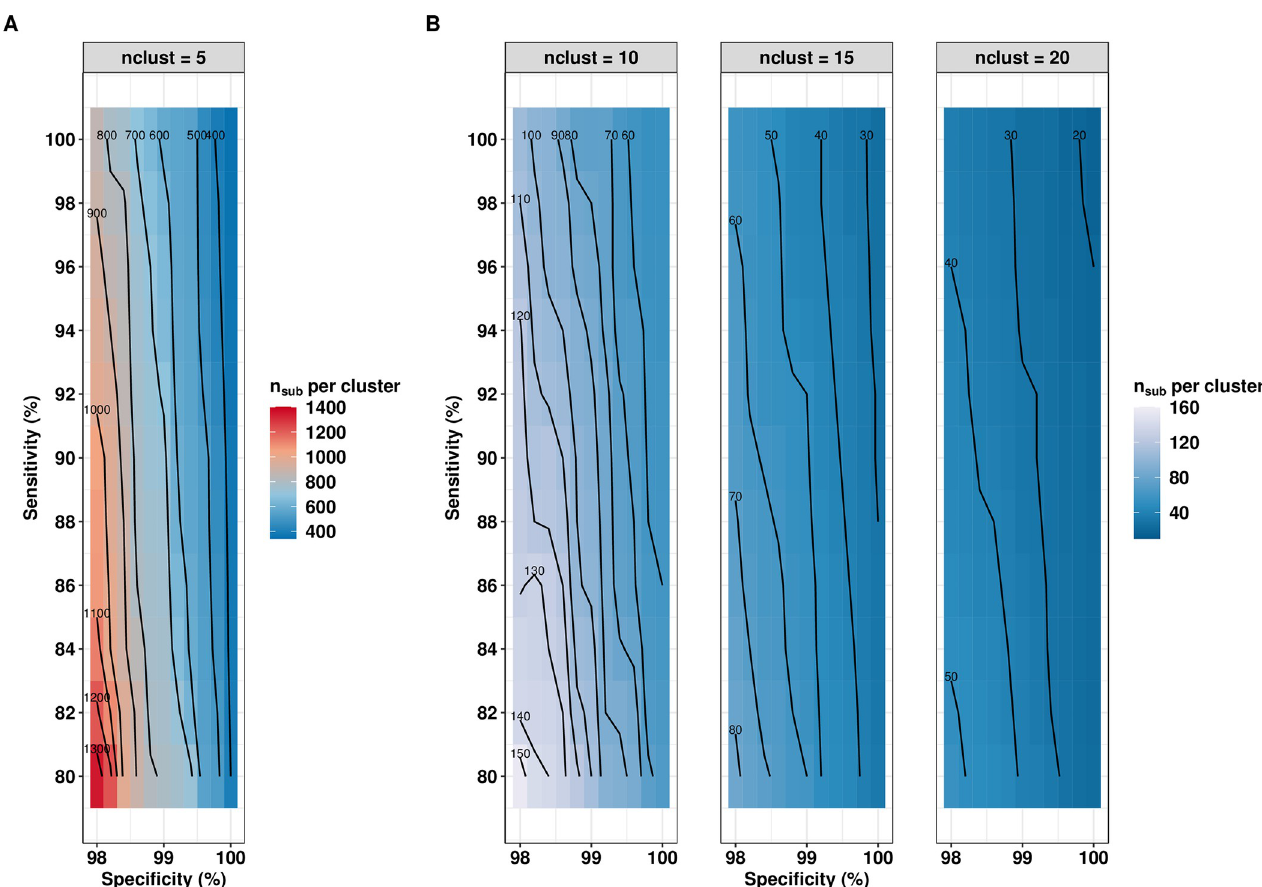
Fig 6. Impact of the diagnostic performance on program decision-making. The contour lines illustrate the relationship between specificity (x-axis), the sensitivity (y-axis), and the minimum number of subjects per cluster n E undertreat = 5 %) around a 2% program prevalence threshold for the number of clusters n clust equal to 5, 10, 15 and 20. We fixed the intra-cluster correlation ρ i at 0.02 and the limits of the grey zone at 1% and 3%. All graphs are based on the same set of 10,000 Monte Carlo simulations.